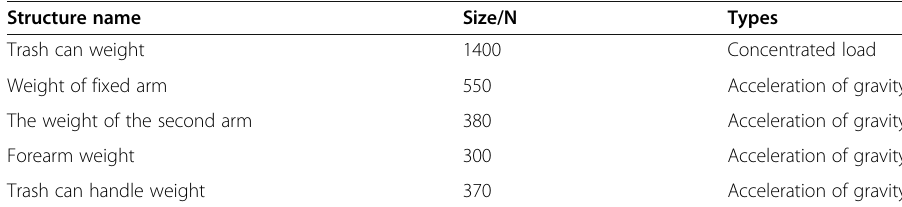
Table 8 Load size of manipulator Structure